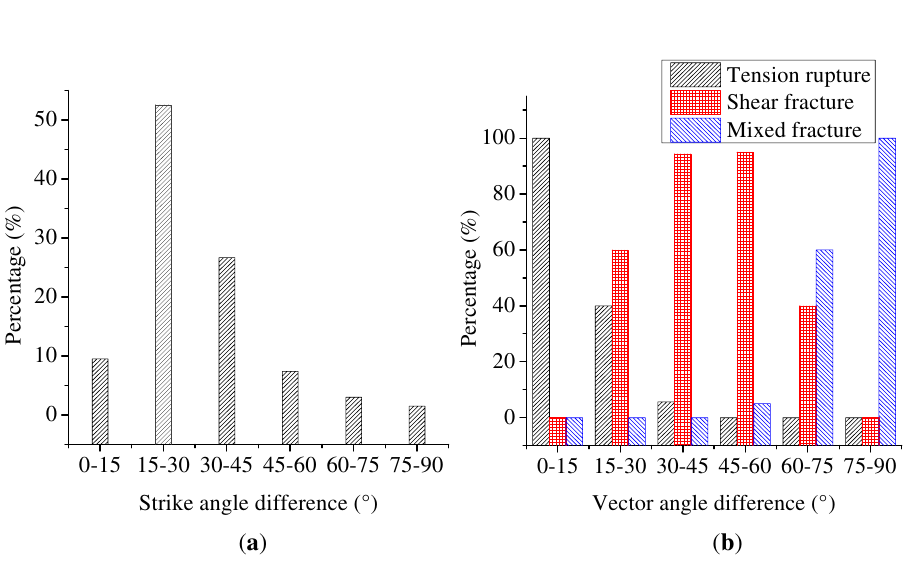
Figure 16. Statistics of fracture events during loading process of gas-bearing coal based on AE moment tensor inversion. ( a ) Difference in the stirke angle. ( b ) Difference in the vector